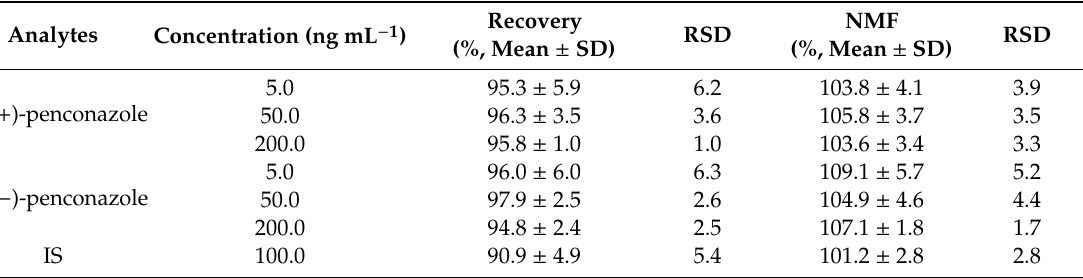
Table 3. The extraction recovery and matrix e ff ect of penconazole enantiomers at three QC levels in rat plasma ( n = 6).